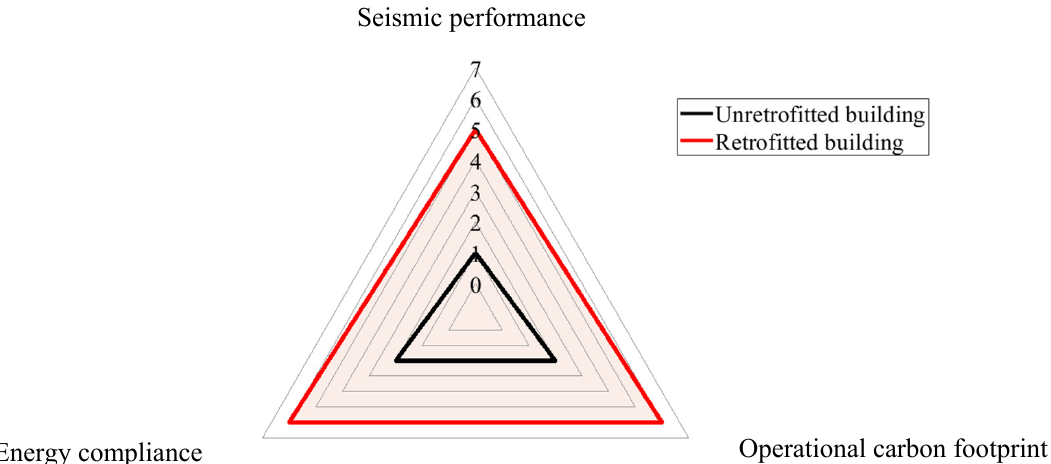
Figure 11. Seismic and Energy Retrofitting Scoreboard: assessment of the unretrofitted and the ret-